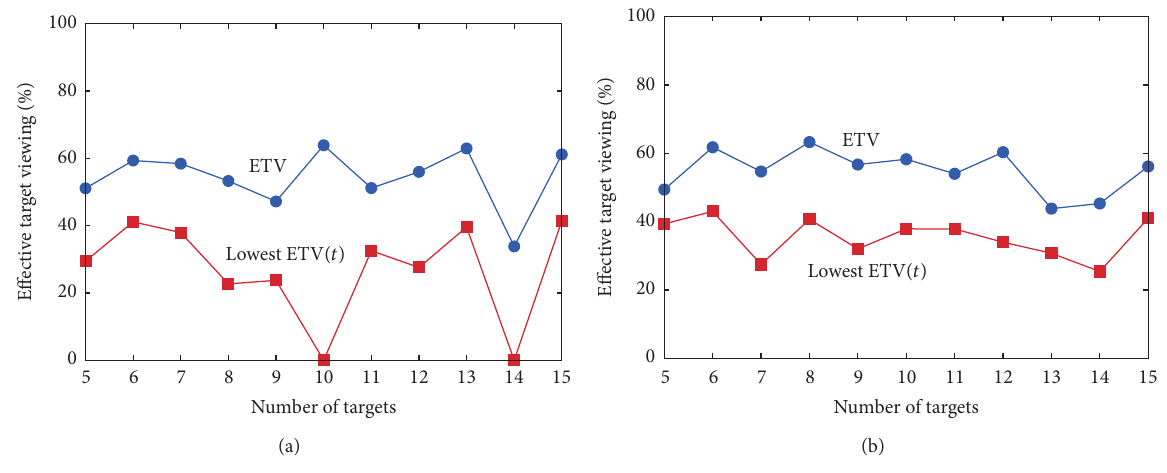
Figure 10: ETV and ETV( 𝑡 ). (a) Targets with 𝑅 (𝑡) = 20 . (b) Targets with 𝑅 (𝑡) = 50 . Table 2: Availability requirements and attainable availability of some visual monitoring applications, for computed ETV and lowest ETV( 𝑡 ) in Figure 10(a).